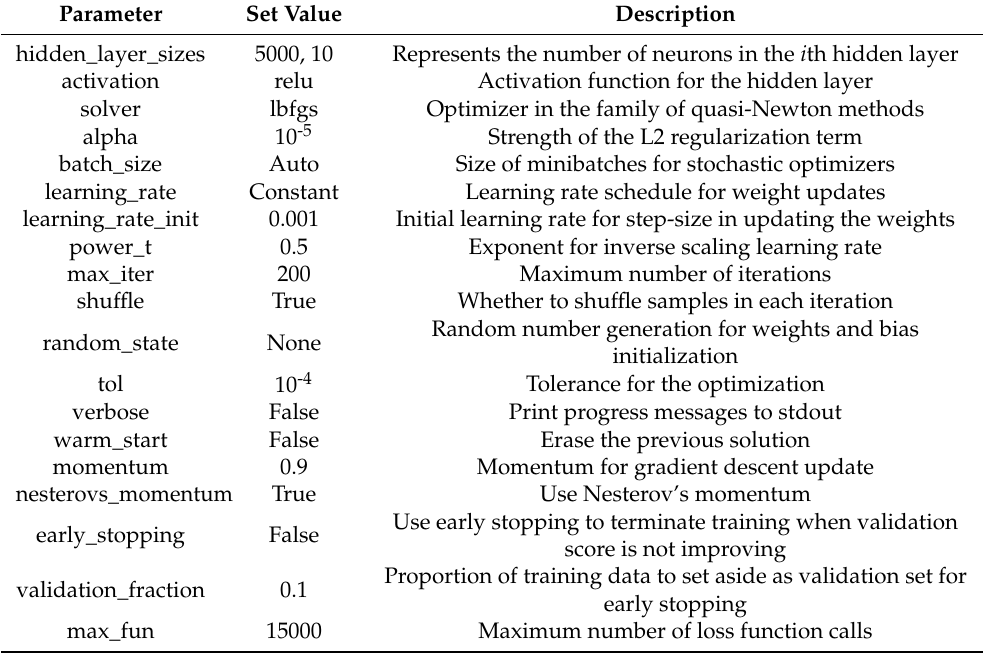
Table 13. Parameters of mechanism set for